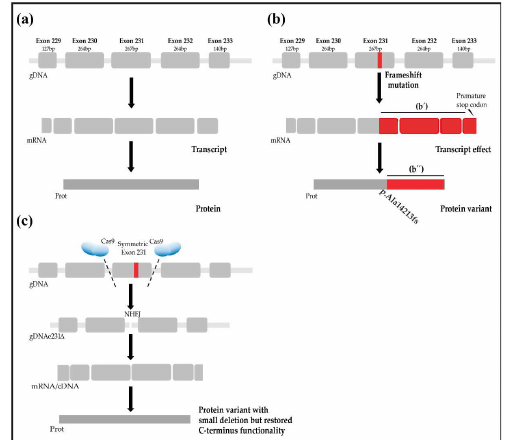
Figure 2. ( a – c ) Overview of the exon deletion approach to restore functional Titin. ( a ) Schematic representation of the canonical transcription and translation of TTN . ( b ) The functional protein is truncated by a point mutation (frameshift). TTNtv leads to (b’) a shifted reading frame with a premature stop codon and ultimately to a protein with (b”) a non-sense C-terminus. Exemplarily presented with a frameshift mutation in exon 231 of TTN that leads to a truncated and partially non-sense version of the protein. The red color indicates a non-sense amino acid sequence different from TTN that originates from the frameshift mutation. The frameshift causes, at the same time, the introduction of a stop codon on the transcript level, which in turn results in a truncated protein variant. ( c ) Symmetric exon deletion to restore TTN functionality. Symmetric exons with mutations are deleted with a system combining Cas9 plus two gRNAs, targeting intronic sites up- and down-stream of the candidate exon. TTN expression results in a minimally shorter but putatively functional protein. Schematic representation of the deletion of a symmetric exon to remove the frameshift mutation located in exon 231. Double strand breaks in TTN are repaired after CRISPR/Cas9 editing without the need for a homologous template by non-homologous end joining (NHEJ). Genes 2022 , 13 , x FOR PEER REVIEW